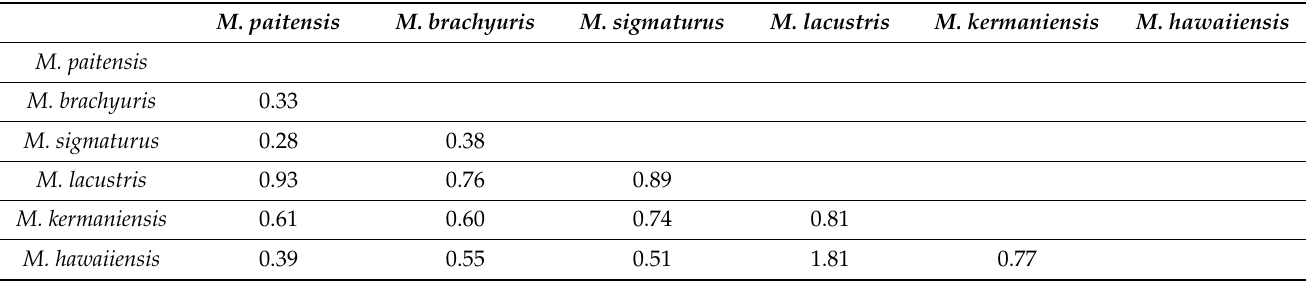
Table 6. Pairwise distance between the populations of Mylonchulus using Primer 7